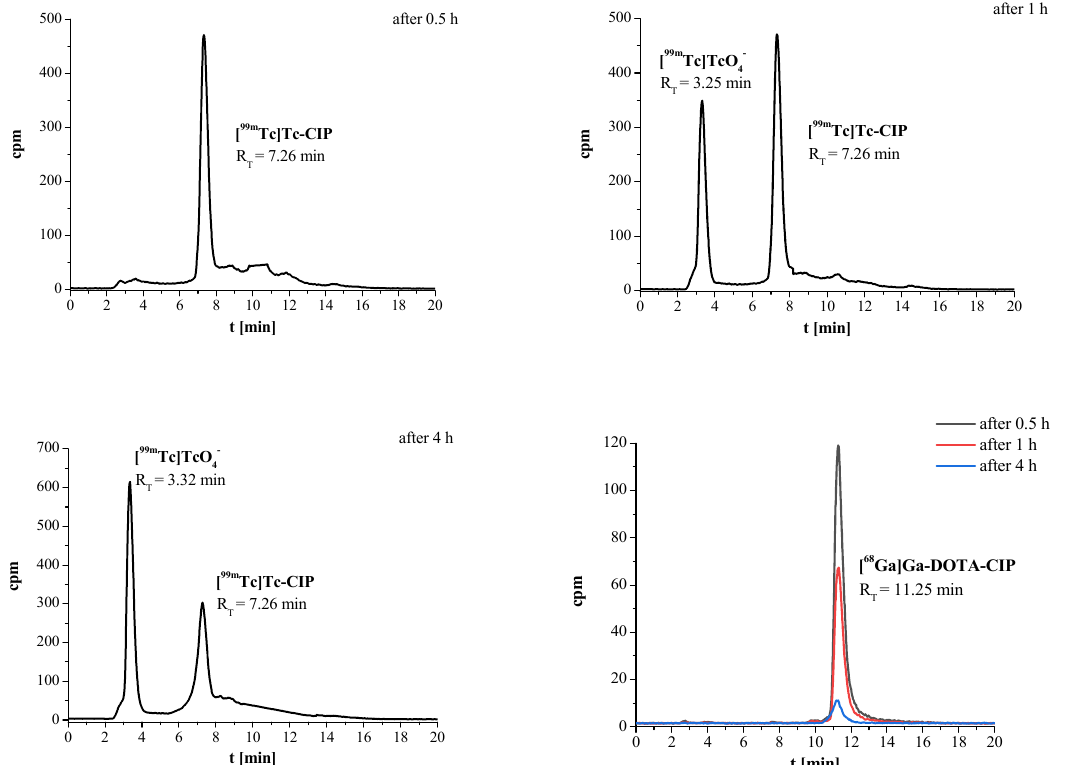
Figure 5. HPLC radiochromatograms of stability of [ 99m Tc]Tc-CIP and [ 68 Ga]Ga-DOTA-CIP radioconjugates during incubation in HS.